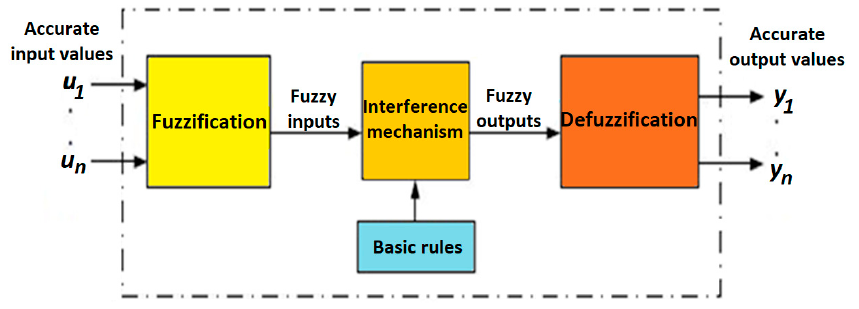
Figure 13. Fuzzy Block diagram.